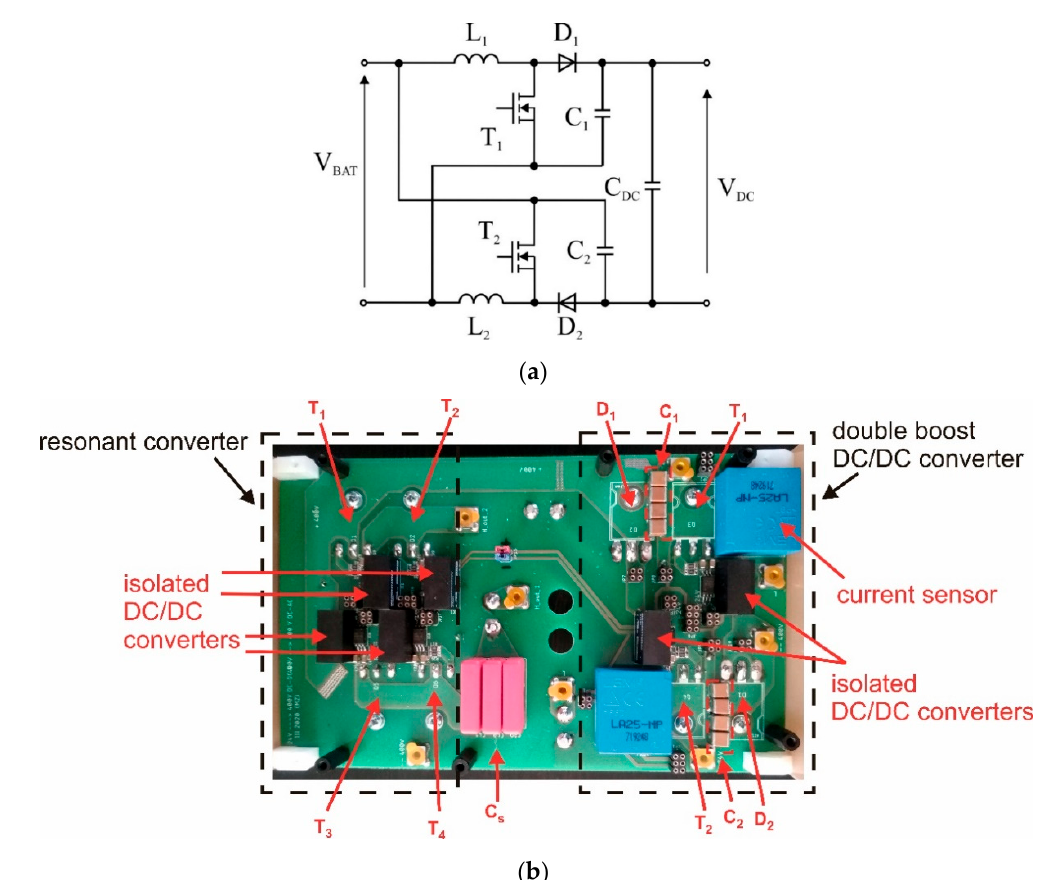
Figure 4. Scheme of the double-boost DC-DC converter ( a ) and top view of the common power board with designed prototype ( b ).